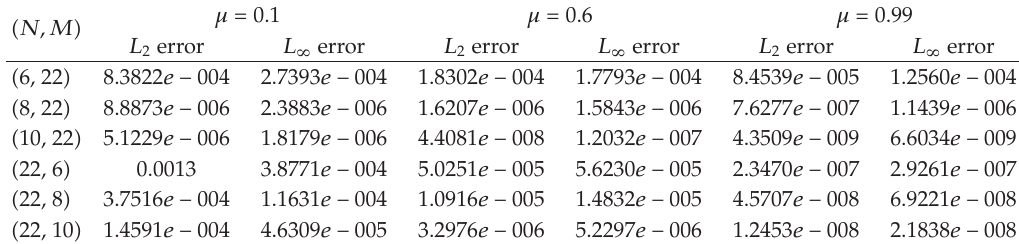
Table 1: L 2 errors and L ∞ errors varying with (cid:4) N , M (cid:5) and μ .